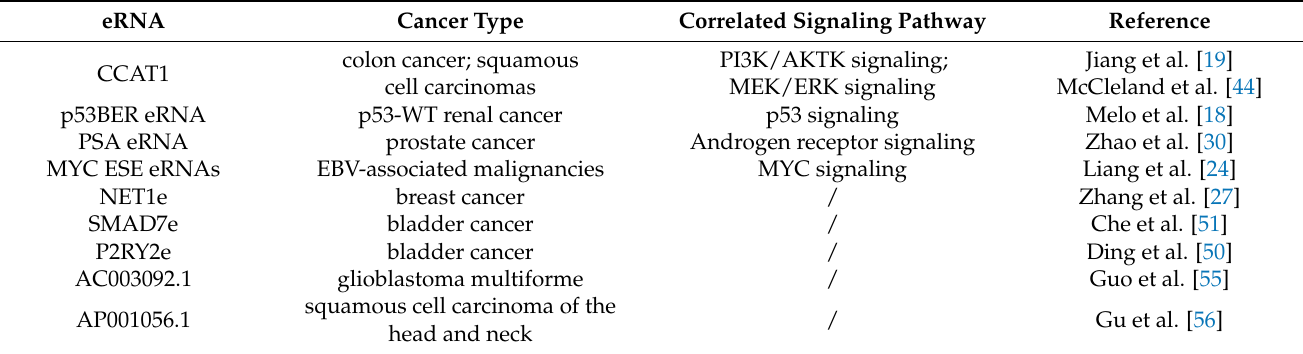
Table 1. eRNAs involved in different cancer types and the correlated signaling pathways. eRNA Cancer Type Correlated Signaling Pathway